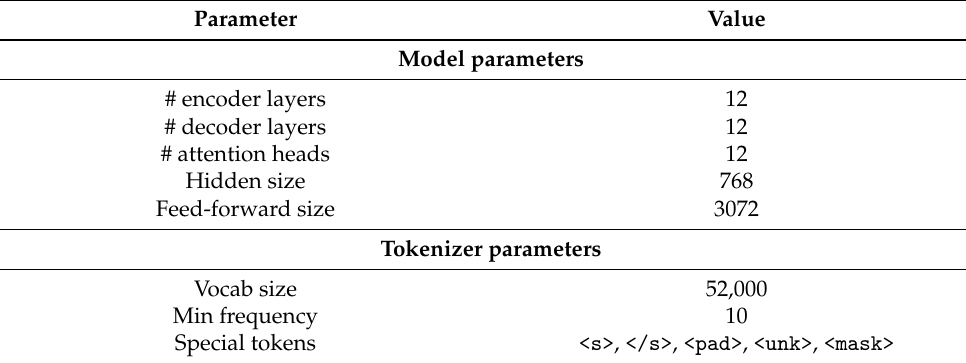
Table 2. Training parameters used for BART-IT and the corresponding